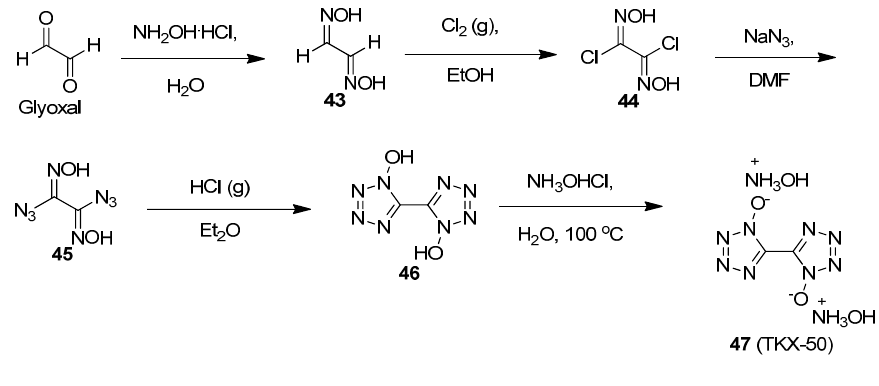
Scheme 12. Synthesis of TKX-50 (47).